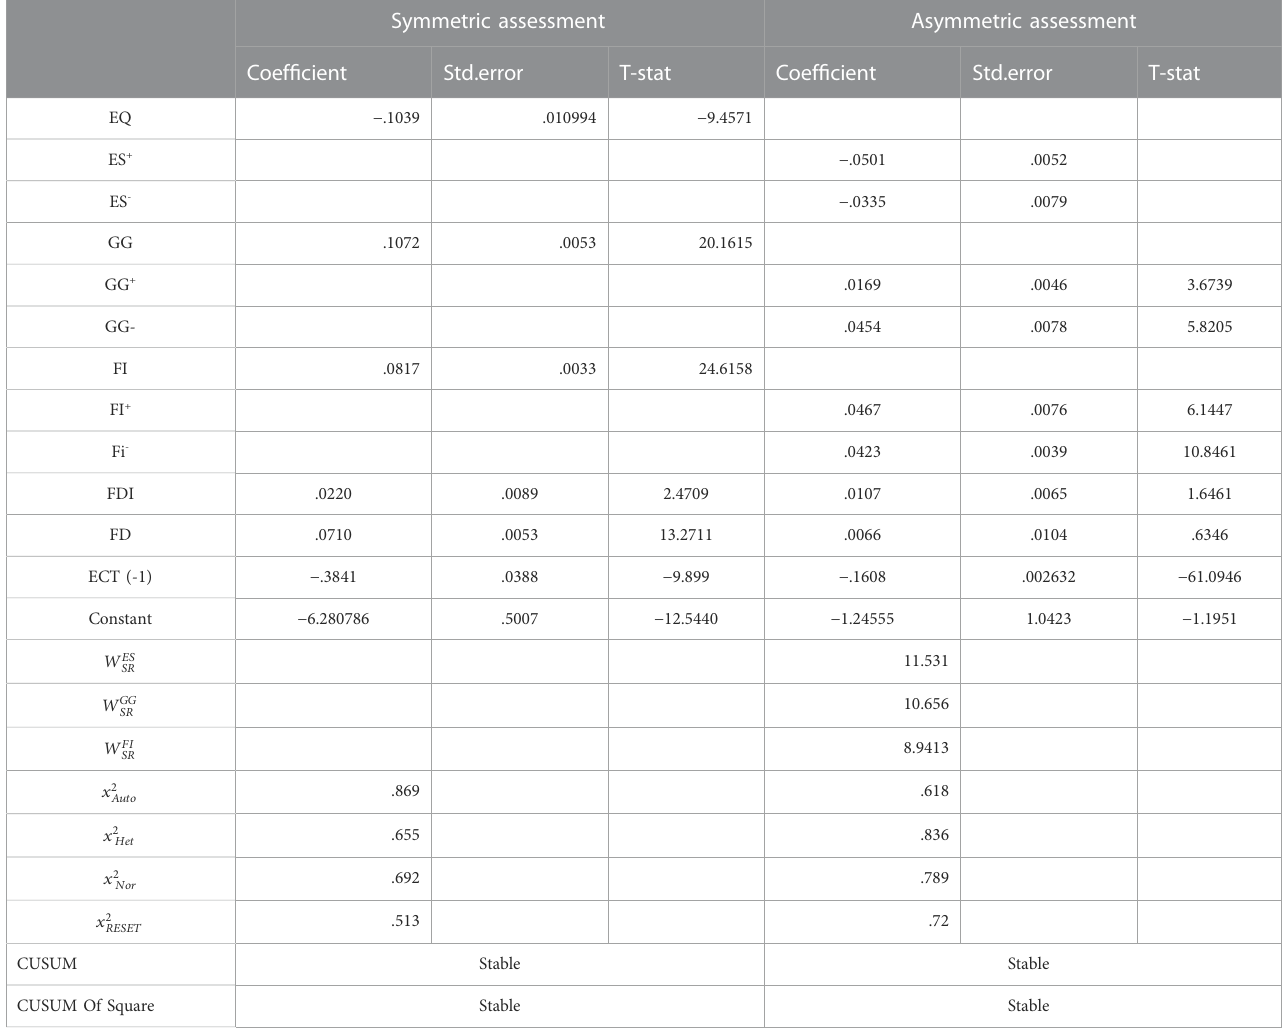
TABLE 9 Results of short-run coef fi cients: symmetric and asymmetric